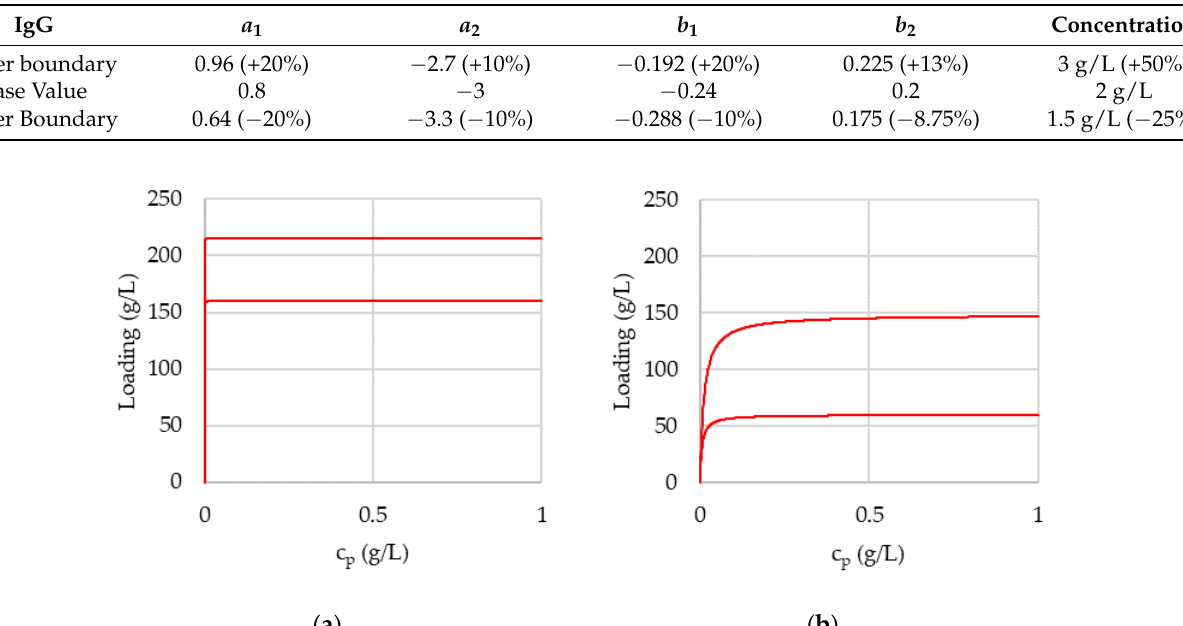
Table 1. IgG parameter boundaries for the dataset generation.